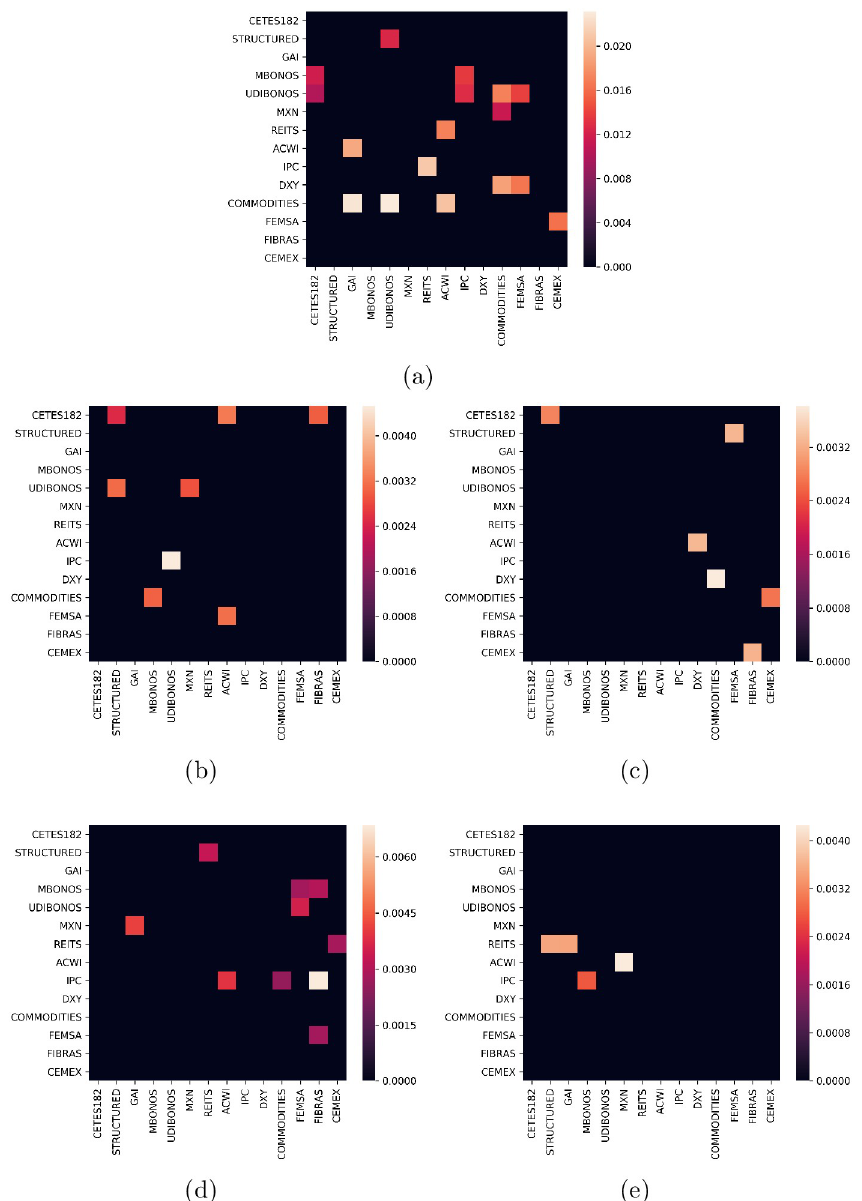
Fig 5. Effective transfer entropy. (a) Heatmap of ETE over historical returns. Heatmap of ETE over expected returns estimated by (b) EGARCH(1,1), (c) GJR-GARCH(1,1), (d) GARCH(1,1), and (e) SBBS model. In all cases the Markov order is set as k = l = 1. The number of bootstrap replications for each direction of the estimated transfer entropy is chosen as B = 300 with 100 shuffles. The first 50 observations of the bootstrapped Markov are